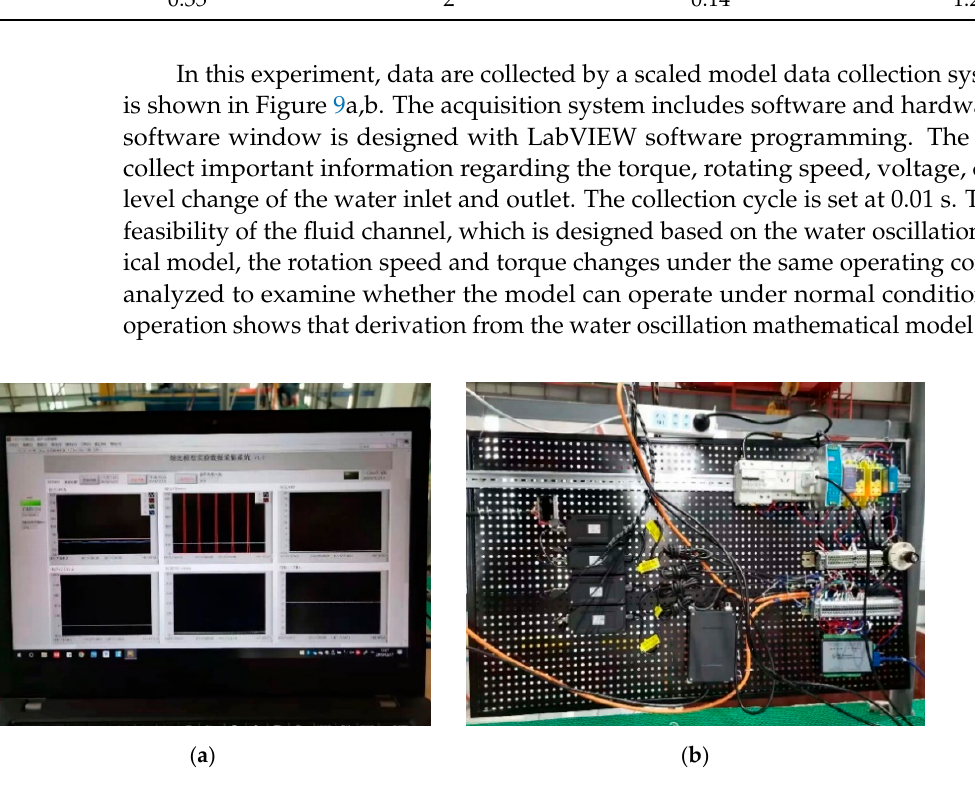
1.47 N.m, the average rotating speed is 29.73 r/min, and the generator can operate nor-